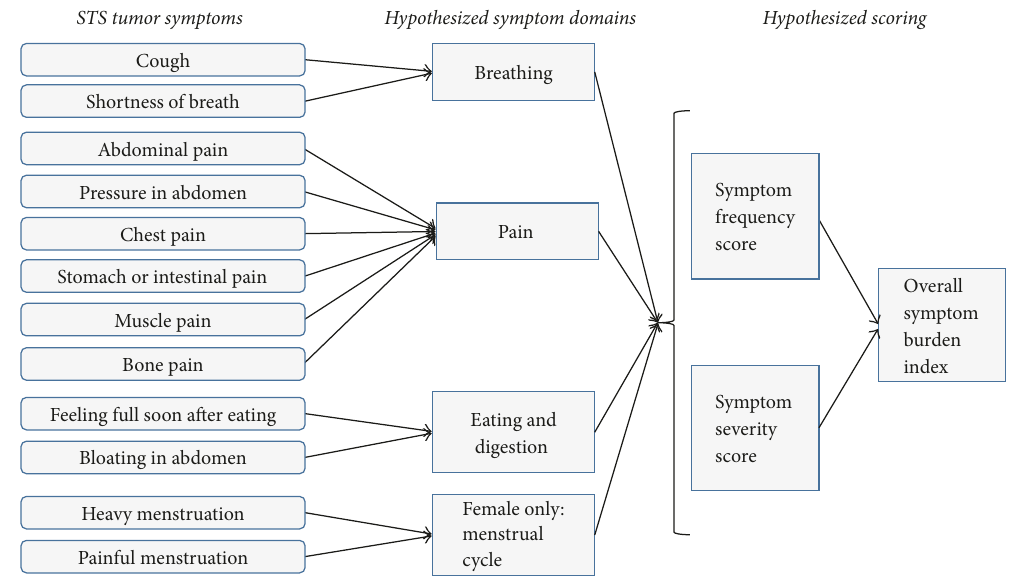
Figure 3: Draft conceptual framework for STS symptom